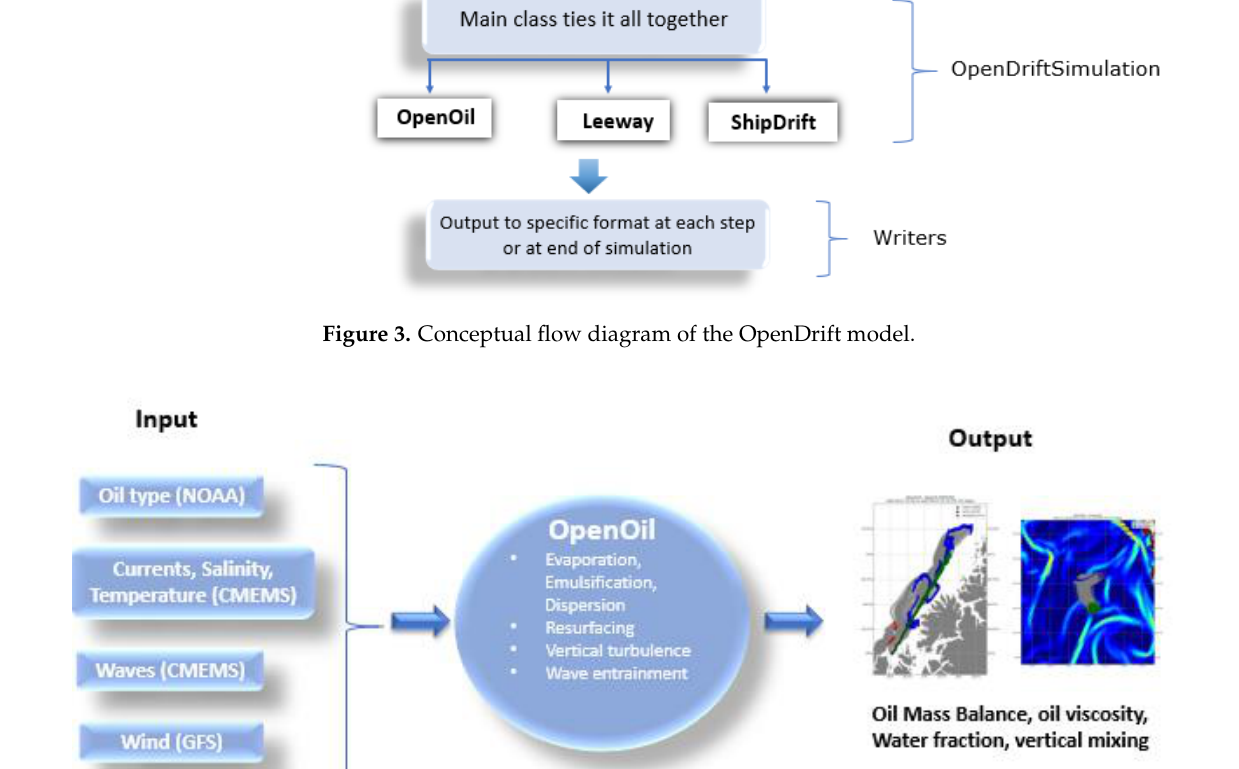
Figure 4. Schematic diagram with methodology of the OpenOil model.